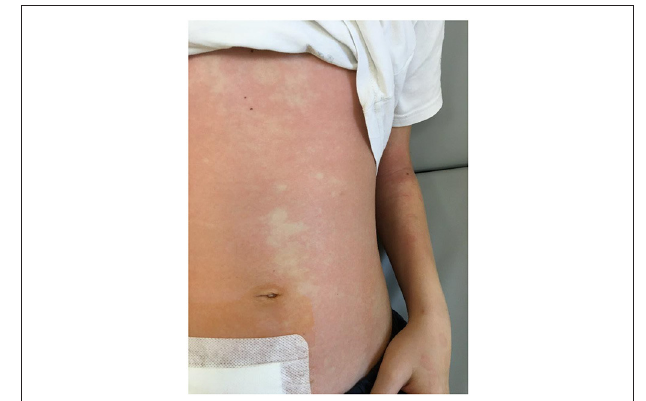
FIGURE 1 | Skin lesions.